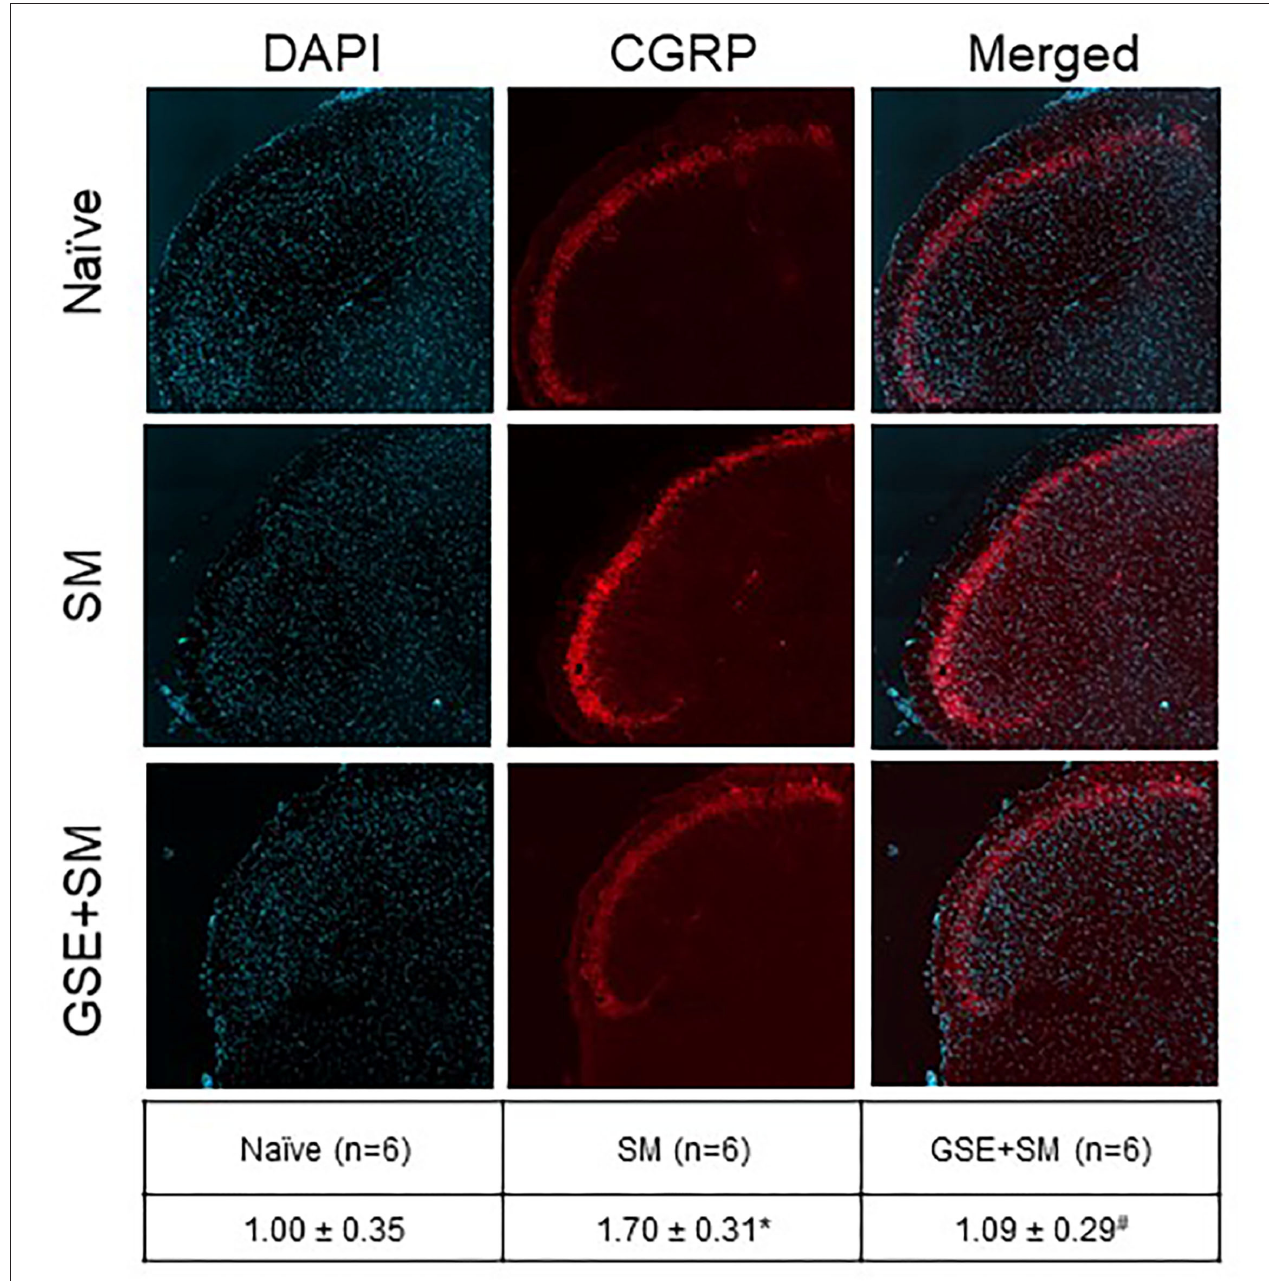
FIGURE 5 | Dietary supplementation with GSE inhibits the elevated level of CGRP expression in the medullary horn mediated by exposure of restraint stressed female animals to a pungent odor. Tissues from the upper spinal cord were obtained from Naive animals, 2h post odor exposure in stressed animals (SM), and 2h post odor exposure in stressed animals that received GSE continuously in their drinking water (GSE + SM). Representative images of tissues costained with the fluorescent nuclear dye DAPI (left panels) , CGRP (middle panels) , and merged images (right panels) are shown. The average relative CGRP immunostaining intensity ± SEM as compared to levels detected in Naïve samples (mean value set equal to 1) is reported in the table. * P < 0.05 when compared to Naive levels, # P < 0.05 compared to SM levels.